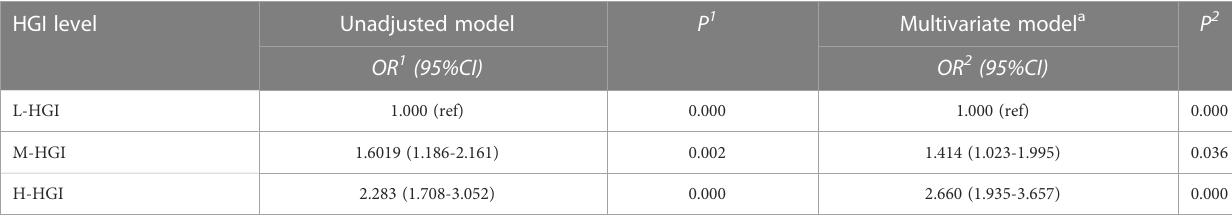
TABLE 3 Logistic regression analysis of the relationship between HGI and DKD in T2DM.